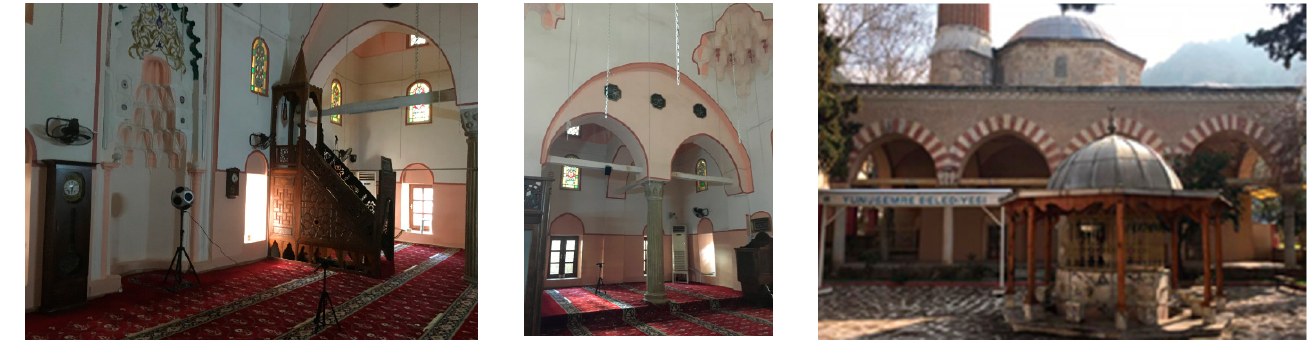
Figure 3. Main prayer hall and side aisle of İ vaz Pa ş a Mosque (photos by the authors).